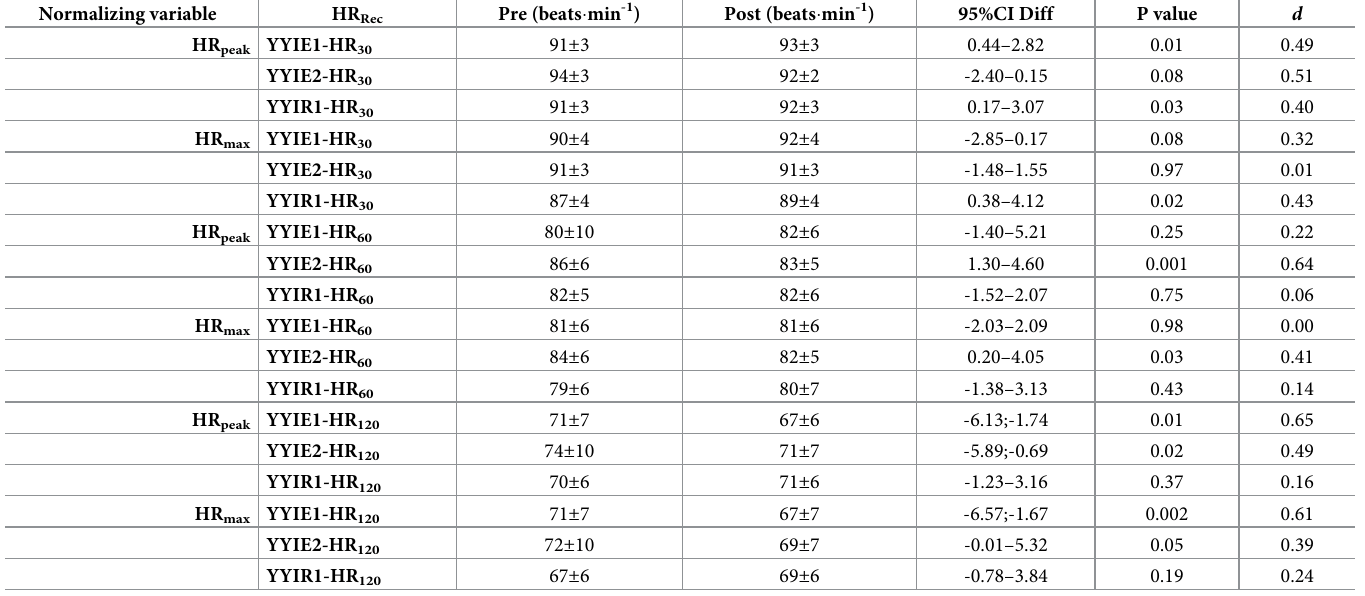
Table 3. Heart rate (HR) recovery values (%) at selected time points before (pre) and after (post) the training intervention and considering test peak HR (HR peak ) and across tests maximal HR (HR max ), as normalizing variables. Normalizing variable